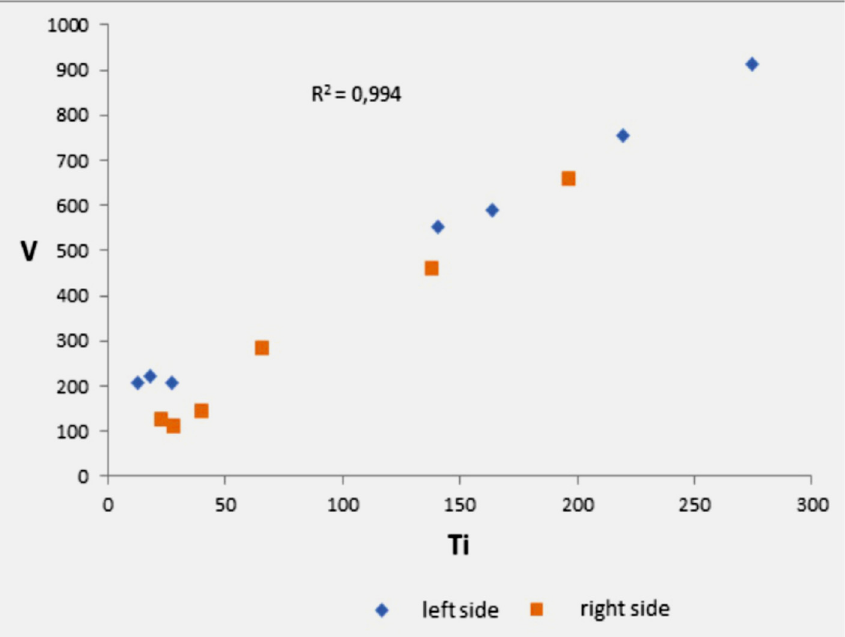
Figure 12. Correlationsof V vs. Ticontents (ppm) from LA ‐ ICP ‐ MS analyses in the blue diopside from the left and right sides of the Sissonevalley.